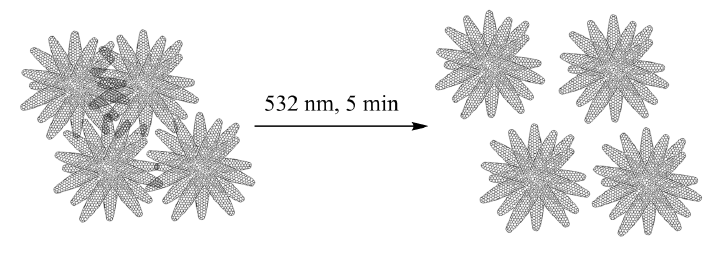
Figure 8. Effect of laser irradiation in CNH aggregates.